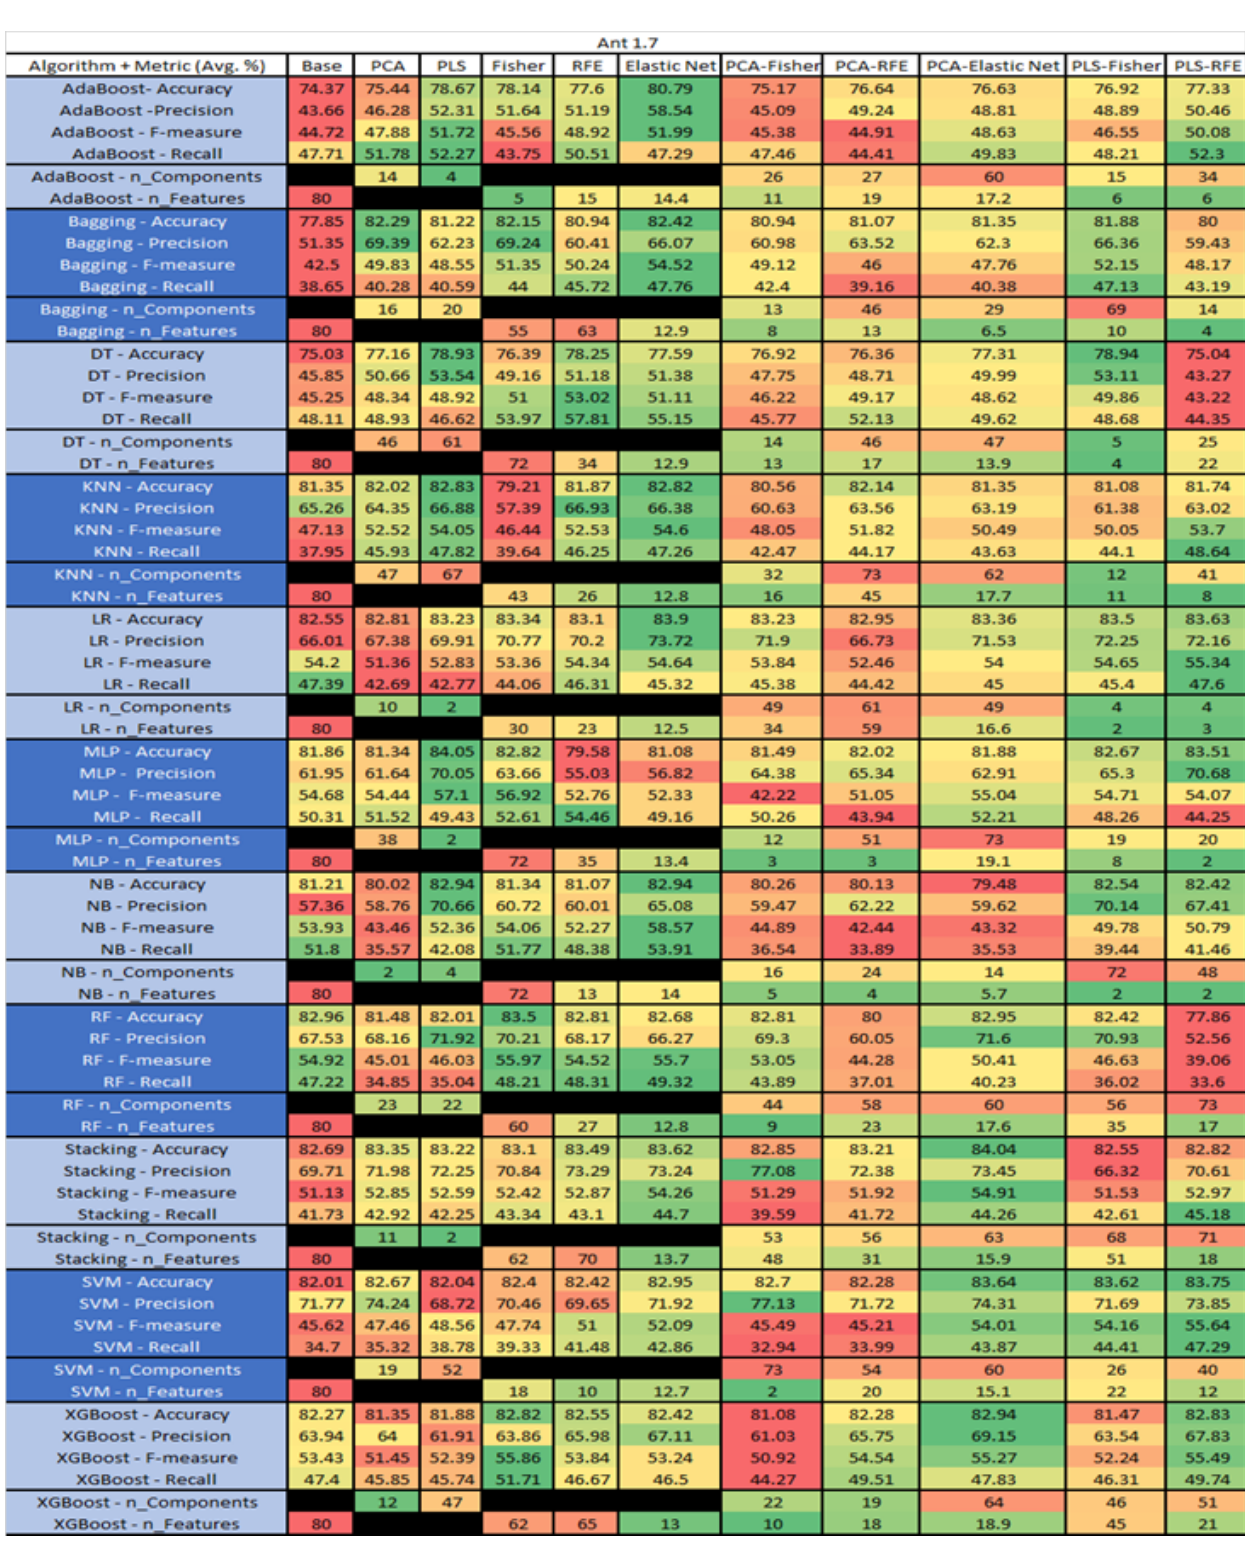
Figure 14. Ant 1.7 PROMISE Results Data